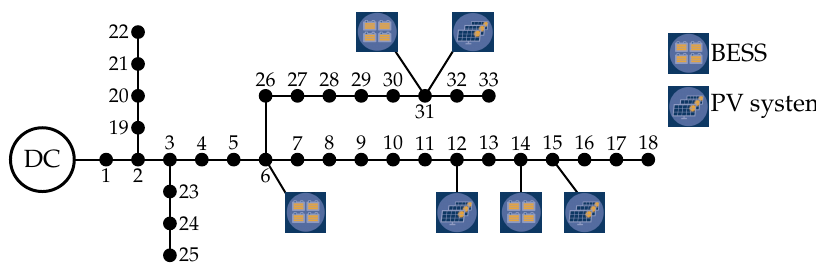
Figure 1. Single-line diagram of the IEEE 33-node grid. The parametric information of this test system is reported in Table